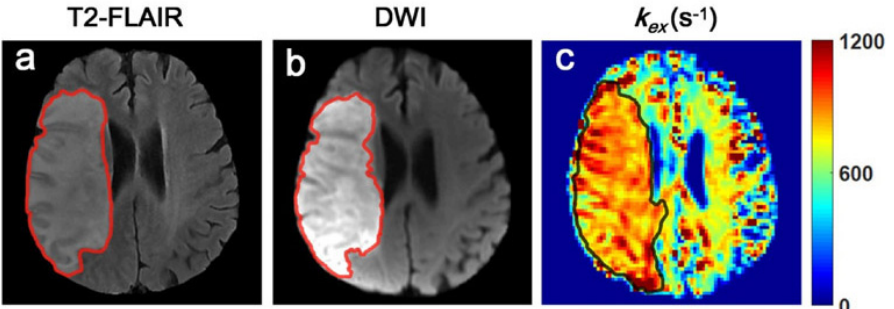
Figure 3. Different MRI images from a representative ischemic stroke patient showing the infarct lesion area. ( a ) T 2 -weighted fluid-attenuated inversion recovery (T 2 -FLAIR) image. ( b ) DWI. ( c ) k ex MRI. The k ex map reflects a larger extent of the infarct lesion with an elevated signal. (Reprinted by permission from J Neurosci Methods. 2020; (346), 108926. Figure 4). In stroke clinics, the definition of ischemic penumbra is useful in the decision for recanalization therapy. The observed mismatch between k ex and DWI maps suggests that k ex MRI may serve as a novel and independent MRI contrast for assessing affected brain tissues in stroke patients and defining ischemic penumbra. Ongoing investigations with longitudinal and histological studies will validate this concept.